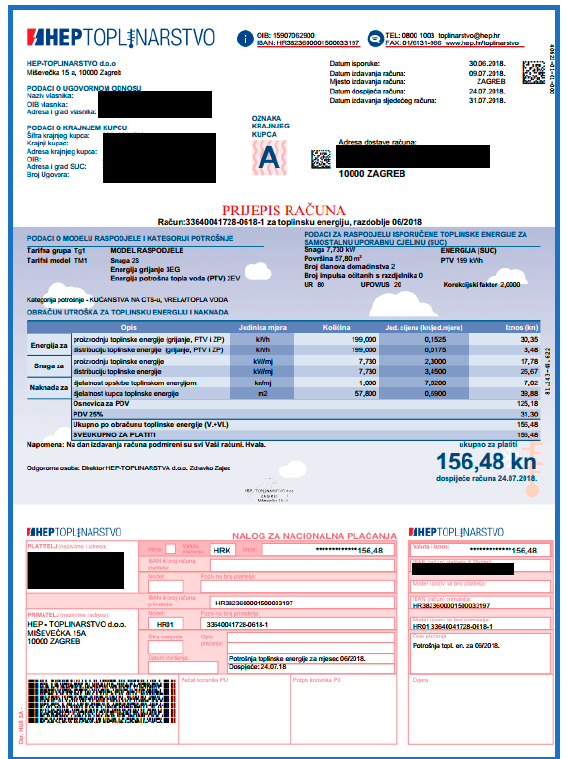
Figure 2. Outlook of the heat bill provided to the apartments in the analysed building and issued by the local district heating company.